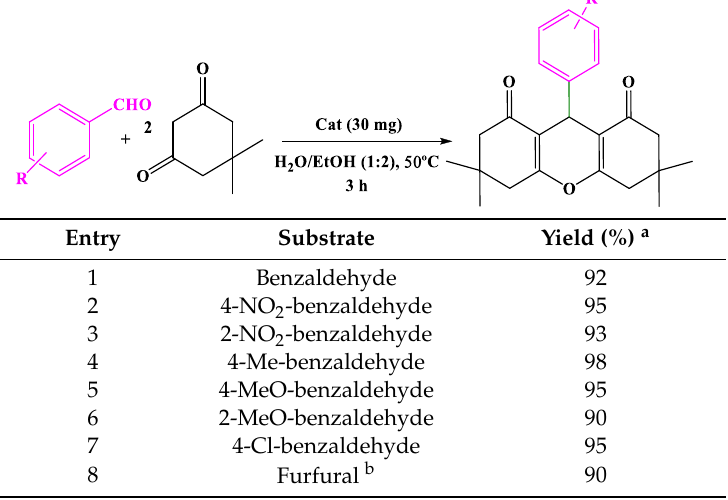
Table 4. Synthesis of various xanthenes under Ag@CDNS-N / PMelamine catalysis.